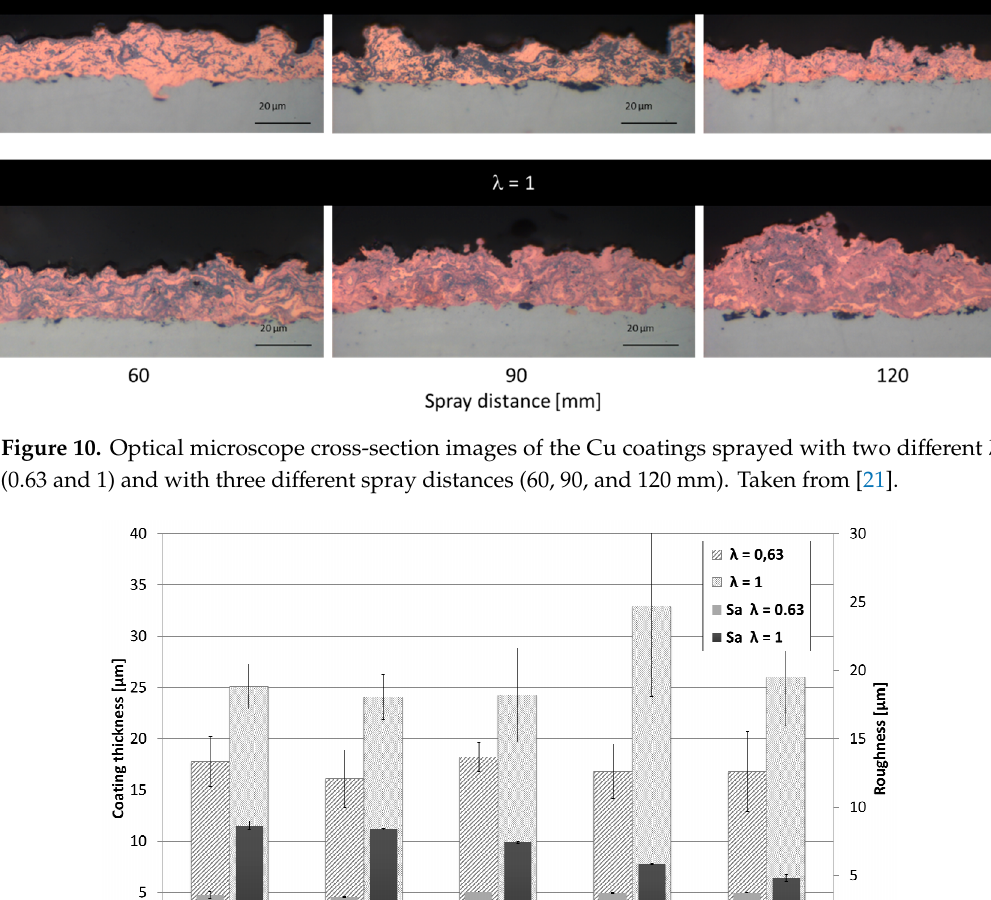
Figure 10. Optical microscope cross-section images of the Cu coatings sprayed with two different λ (0.63 and 1) and with three different spray distances (60, 90, and 120 mm). Taken from [21].